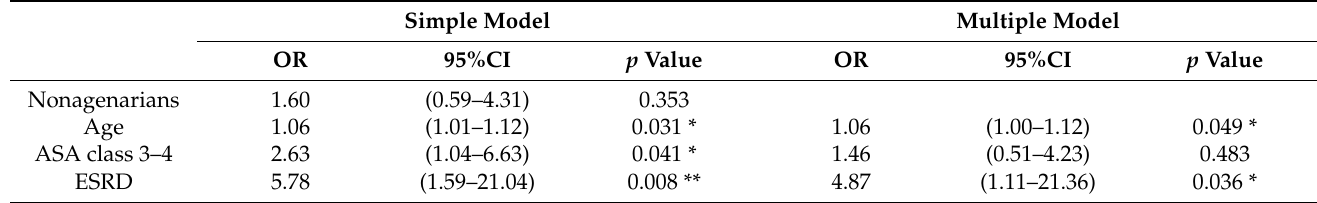
Table 3. Risk factors of complications for whole cohort in logistic regression model. Simple Model